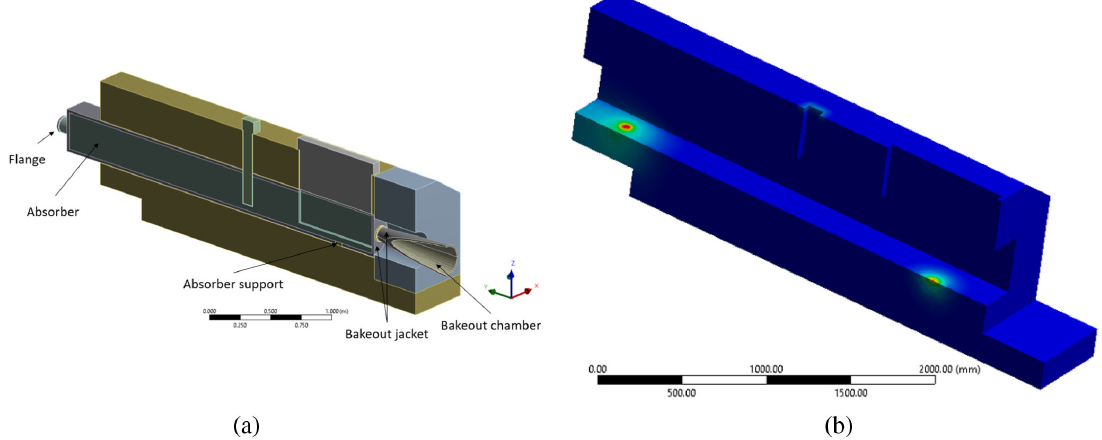
FIG. 9. Bakeout simulation. (a) 3D simulation model for the bake-out cycle. (b) Temperature map of the shielding during the bake-out process.